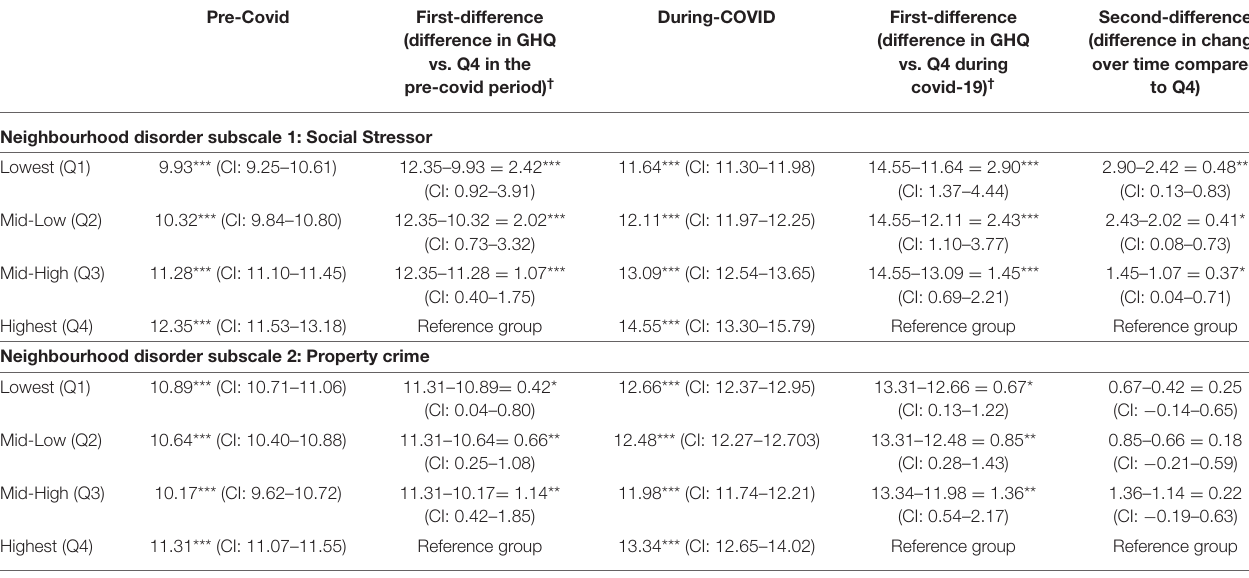
TABLE 2 | Post-test estimation analysis from fixed-effect model predicting change in GHQ predicted